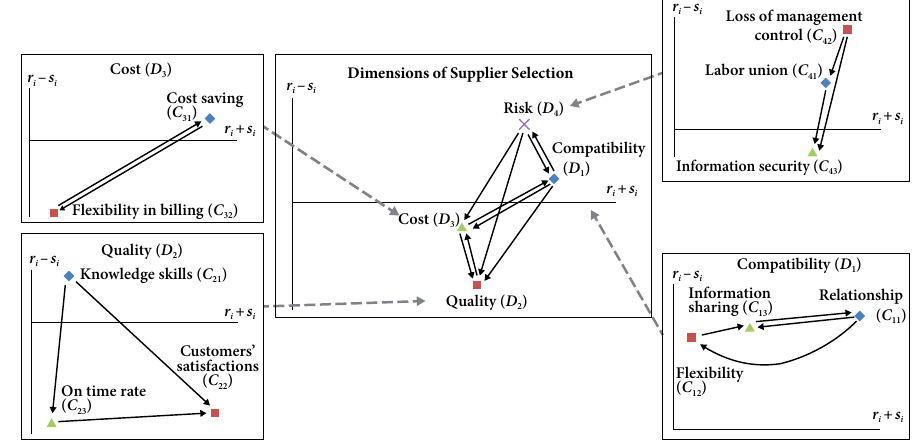
Fig. 4. Influential network-relationship map within systems Source: Liou et al.